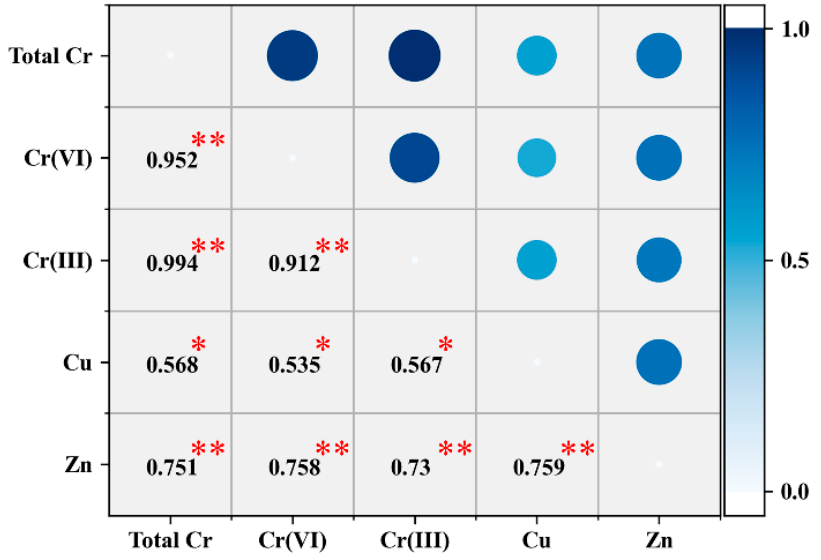
Figure 4. The correlation matrix analysis of the heavy metals in the soils (* = p < 0.05, ** = p <